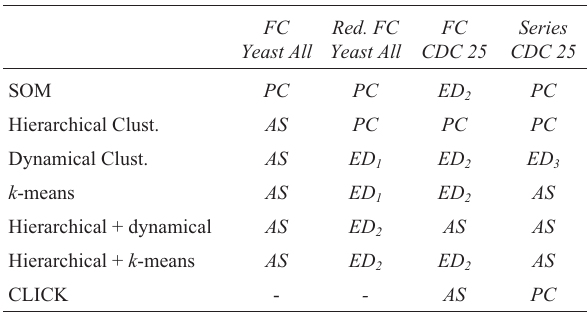
Table 1 - Proximity metrics with best